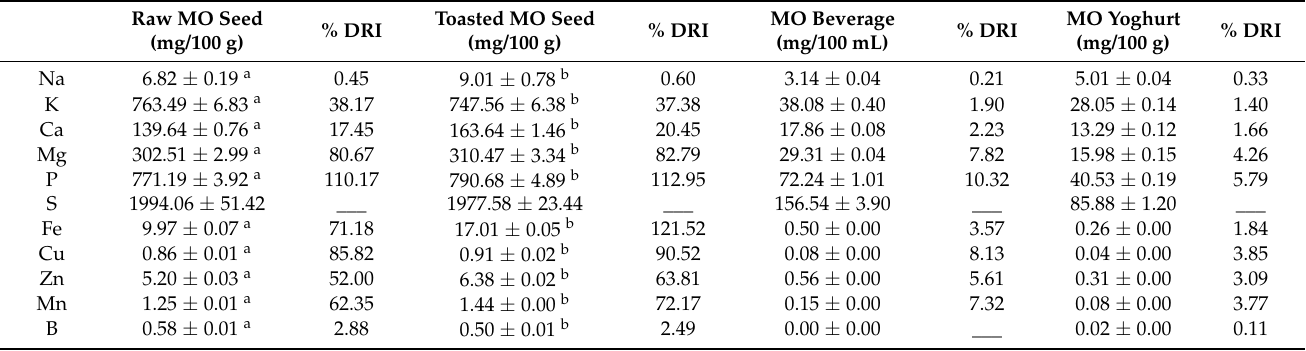
Table 4. Mineral content of M. oleifera seeds (raw and toasted), beverage and yoghurt-like. The mineral contribution of 100 mL of pulse beverage and 100 g of seed or yoghurt, taking into account the dietary reference intakes (DRI) for adults (significant amount of 7.5% for beverage and 15% for seeds and yoghurt) [26] is also presented as a percentage. Values are represented as mean ± SD. Different letters, per mineral element, represent a significant difference between the seed samples ( p <